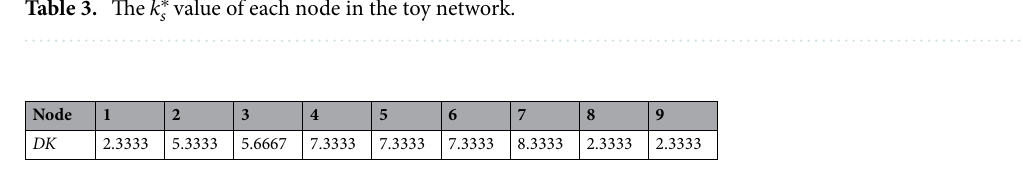
Table 4. The DK value of each node in the toy network.